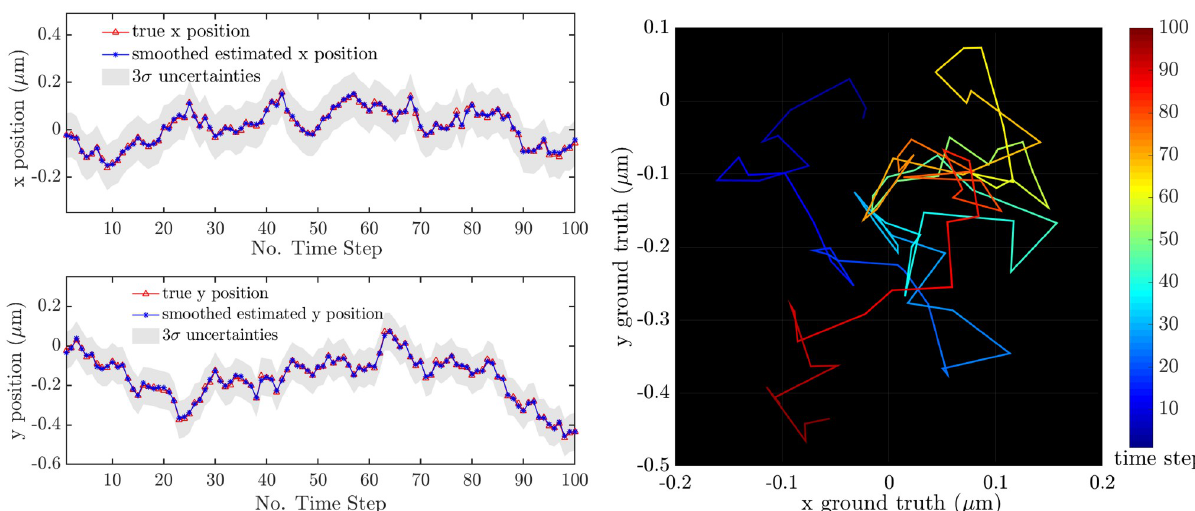
Fig 4. A typical trajectory with D x = 0.005 μ m 2 /s and D y = 0.01 μ m 2 /s. (left) x and y trajectories together with the position estimates from U-EM and the 3 σ error bounds. (right) The ground truth trajectory in the plane with color indicating time.